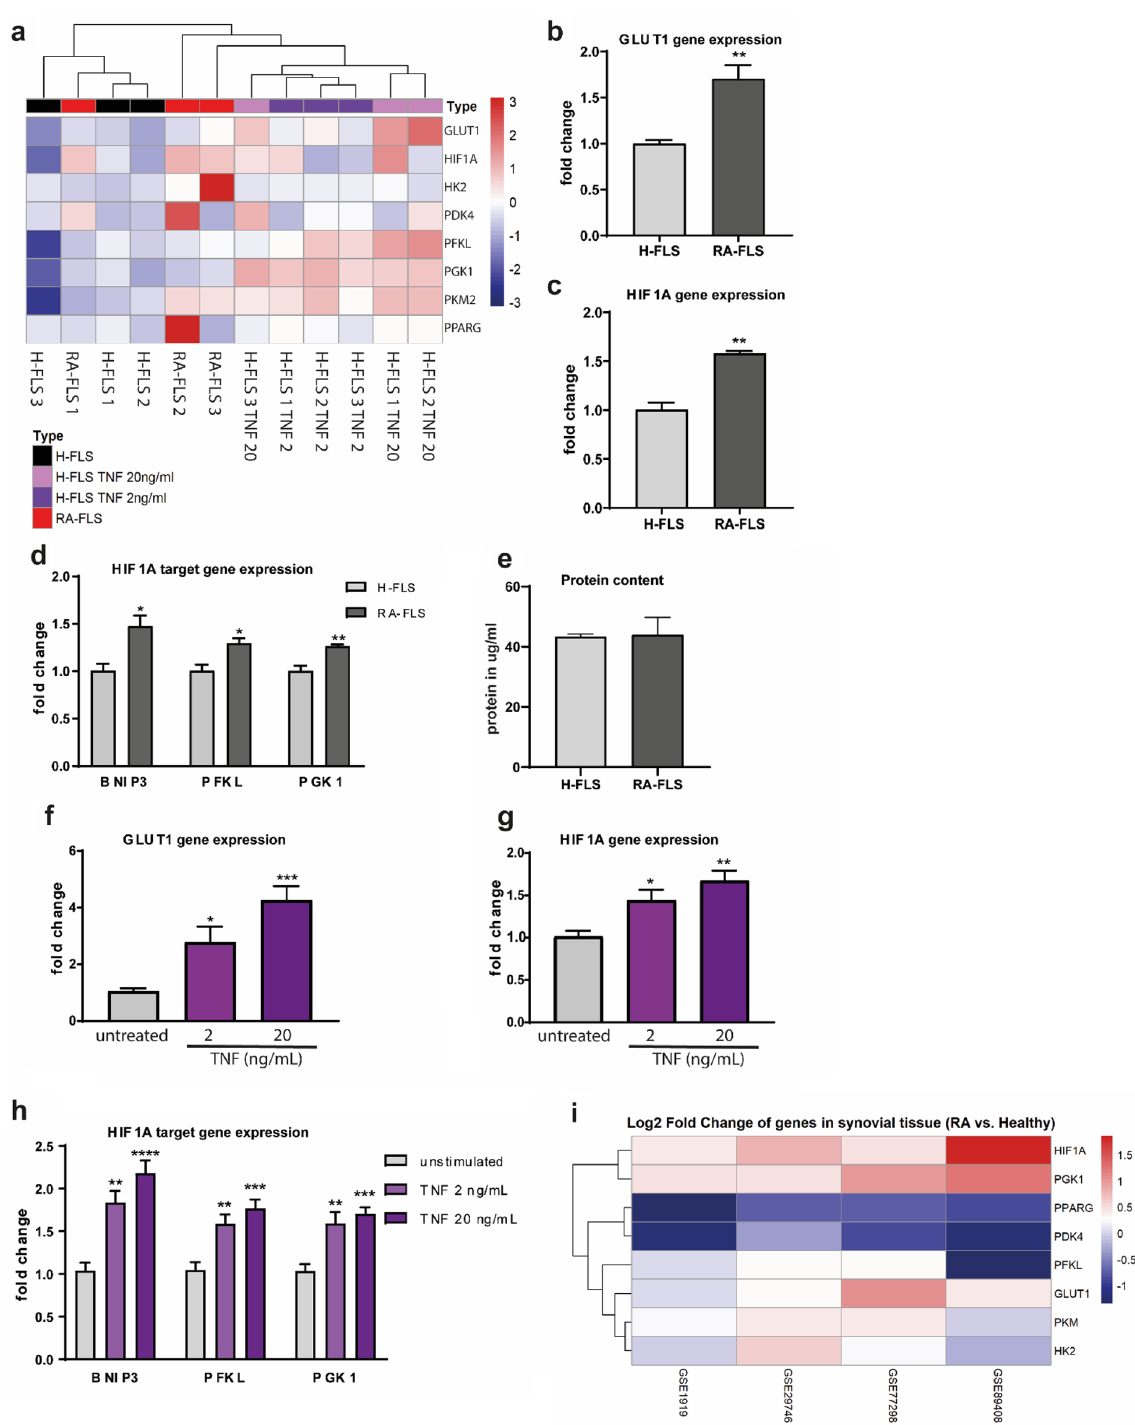
Figure 2. Upregulation of GLUT1 and HIF1A signaling in H-FLS after TNF stimulation and in RA-FLS. Metabolic gene expression in H-FLS and RA-FLS, and H-FLS after 24 h stimulation with recombinant human TNF (2 ng/mL, 20 ng/mL, 3 donors each). ( a ) Hierarchical agglomerative clustering with Euclidean distance, fold change. ( b – d ) Expression of GLUT1 ( b ), HIF1A ( c ) and HIF1A target genes ( d ) in fibroblast-like synoviocytes from healthy or RA donors. ( e ) Protein content was analyzed using BCA assay. ( f , g ) Metabolic gene expression in H-FLS after stimulation with recombinant TNF. Fibroblast-like synoviocytes from three healthy donors were stimulated with recombinant human TNF (2 and 20 ng/ml) for 24 h and expression of GLUT1 ( f ), HIF1A ( g ) and HIF1A target genes ( h ) was evaluated (2 independent experiments, 3 different donors, n = 6). ( i ) Heatmap of DiseaseLand analysis from 4 independent studies, scale reflects fold changes. Values represent means. ± SEM, unpaired t-test ( b – e ) or unpaired one-way Anova with Dunnett correction ( f , g